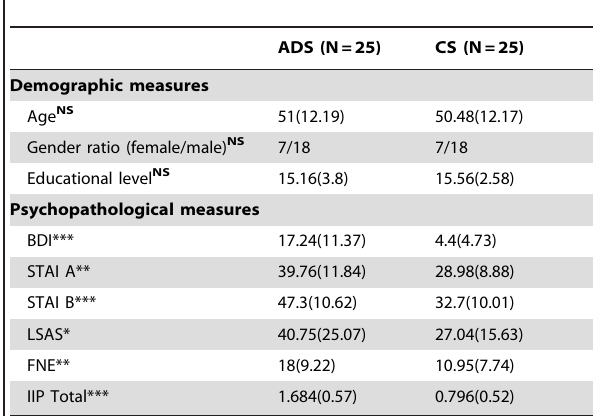
Table 1. Alcohol-dependent (ADS) and control (CS) subjects’ results for demographic and psychological measures: mean